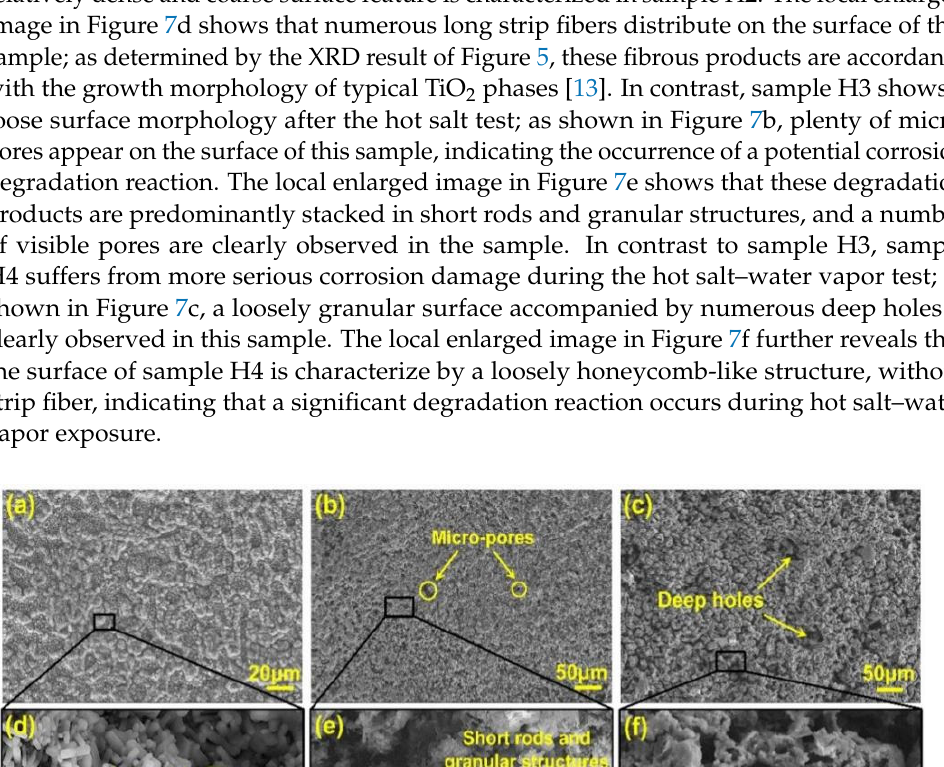
Figure 6. Surface SEM images ( a ), cross-sectional SEM image ( b ), and elemental mappings ( c ) of sample H1.